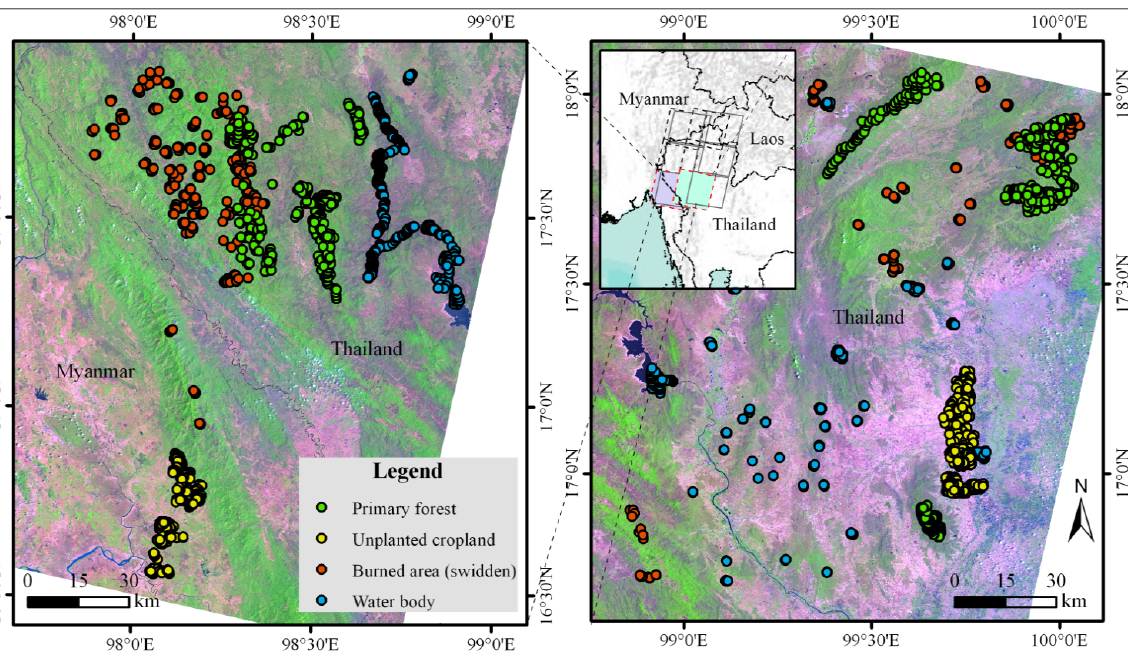
Figure 4. Locations of the 3,311 independent random sample points of four major land cover types in the border area of Myanmar and Thailand. The displayed images are Landsat-8 Pre-WRS-2 products acquired on 27 March 2013 ( left ) and 1 April 2013 ( right